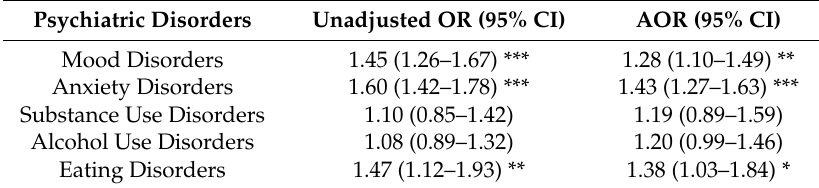
Table 2. Multivariable logistic regression models depicting the associations between lifetime seasonal allergies and lifetime psychiatric disorders ( N = 10,334).